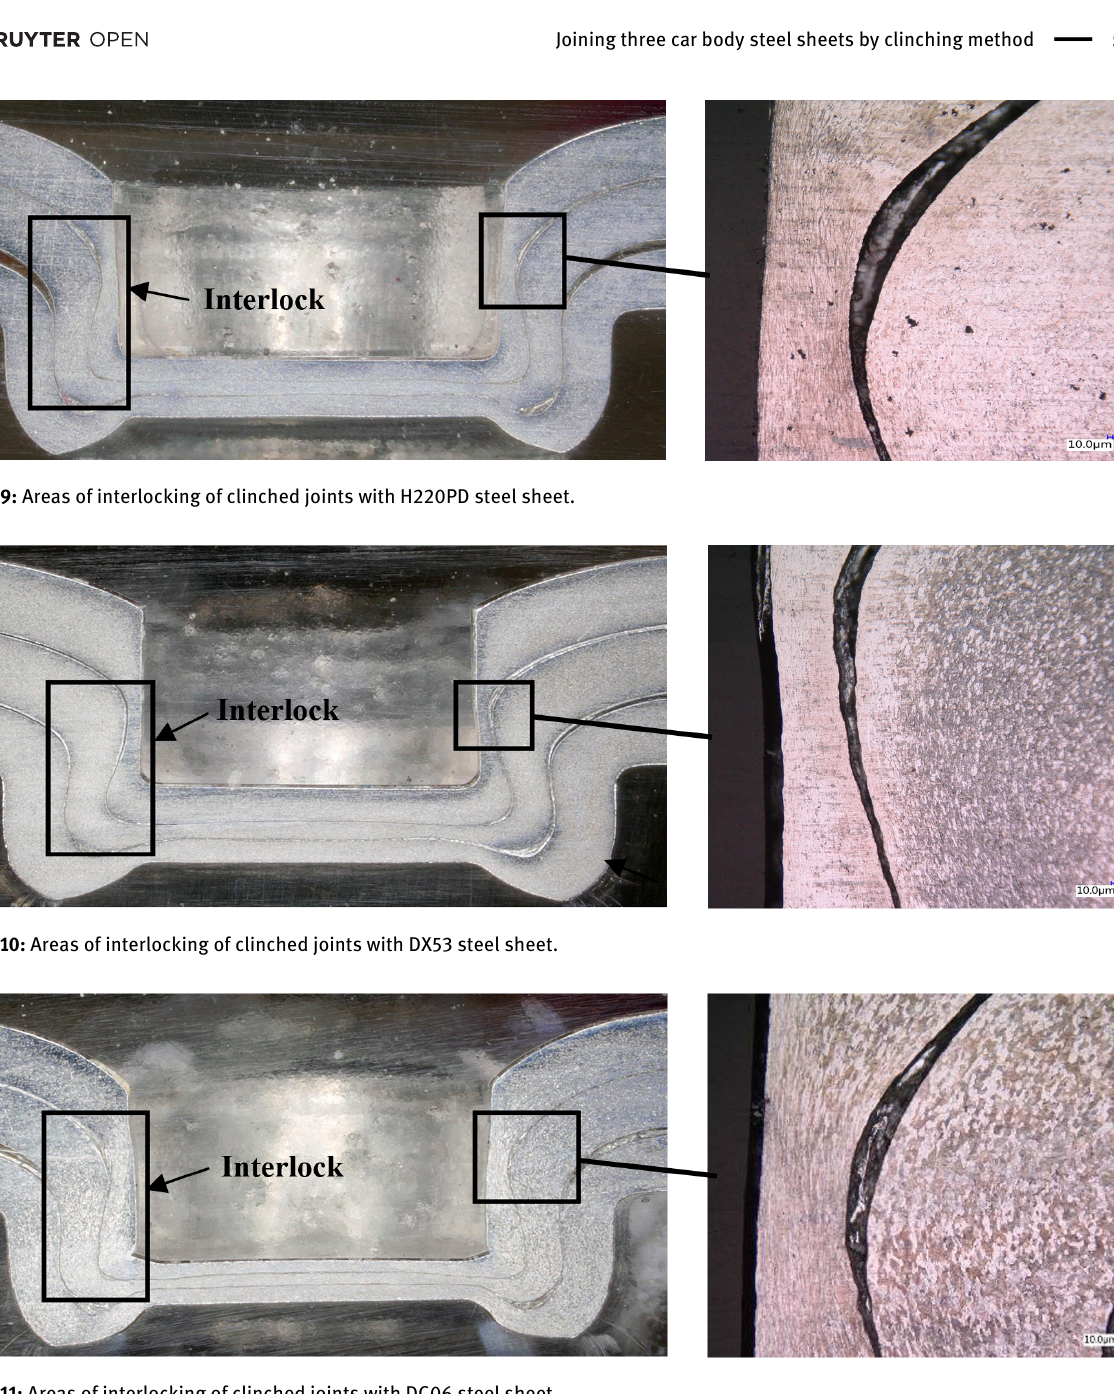
ing, cold hardening leads to high local strength, mainly in the neck